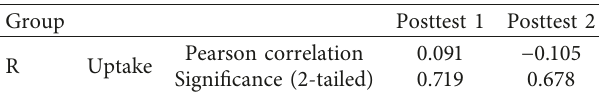
Table 13: Correlations between measures of uptake and posttests for the R group. Group